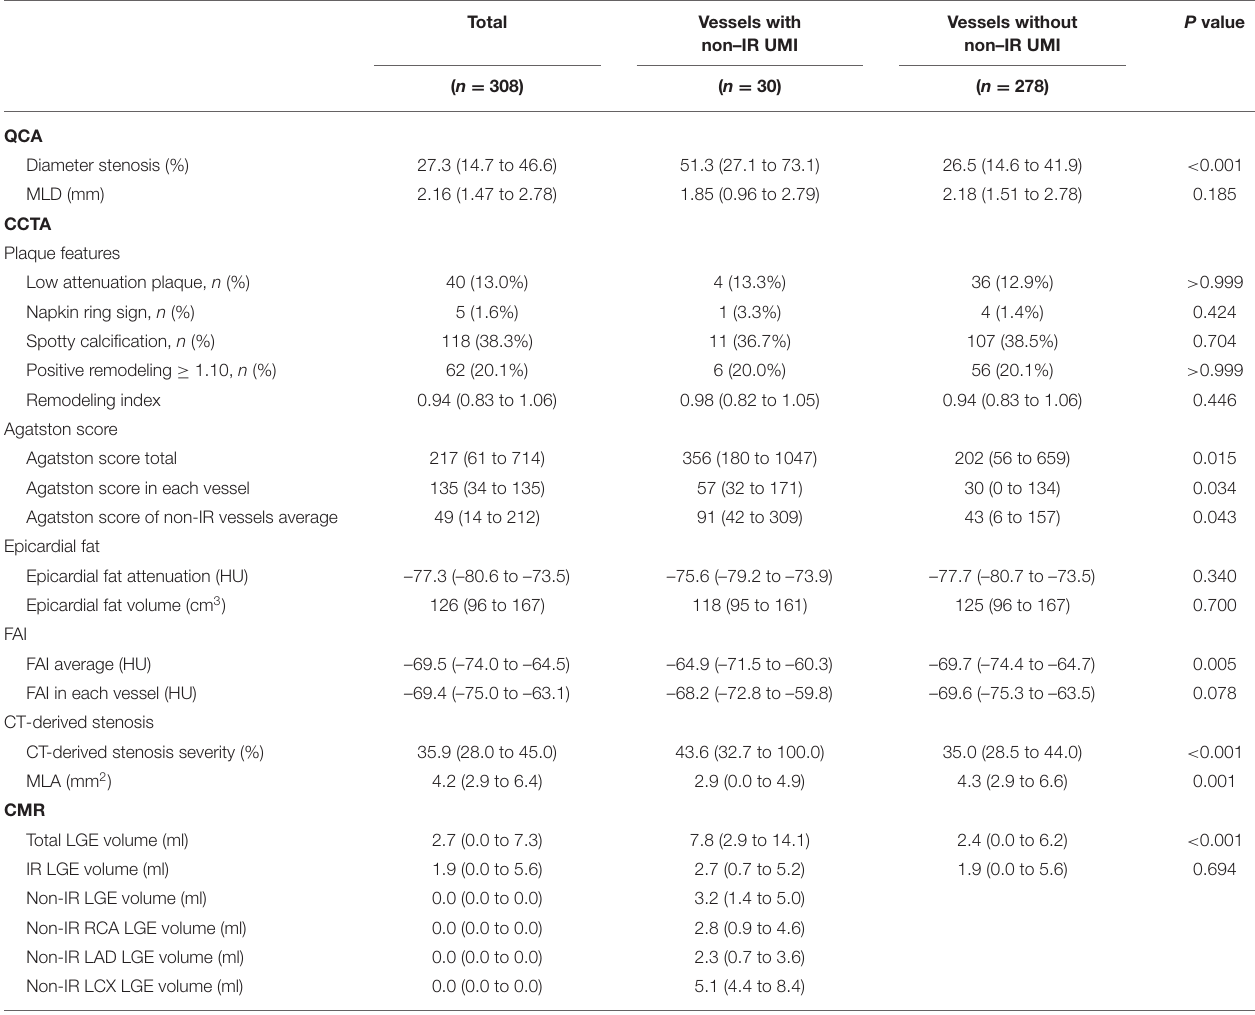
TABLE 2 | QCA, CCTA, and CMR